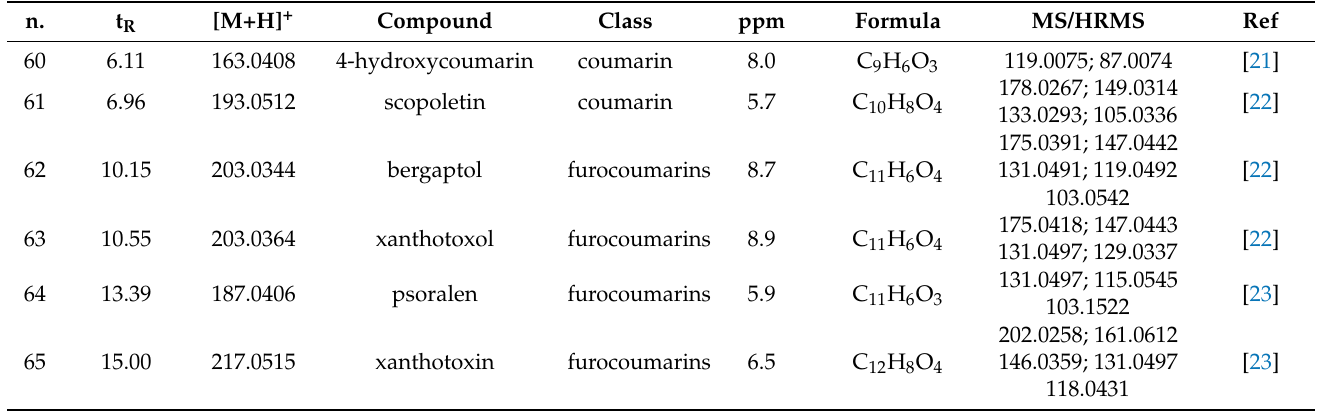
Table 2. LC-MS data for coumarins, furocoumarins, and limonoids detected in chloroform peel, pulp, albedo, and seed extracts of Faustrime